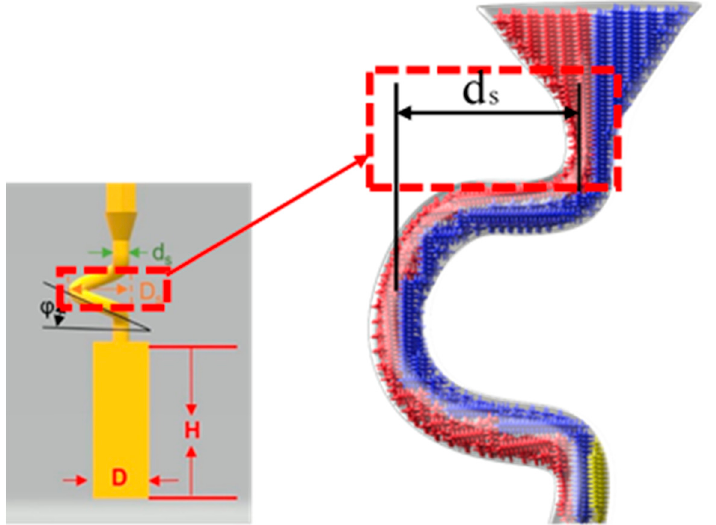
Figure 9. Schematic drawings of a 2D grain selector compared with a spiral selector in pitch length.